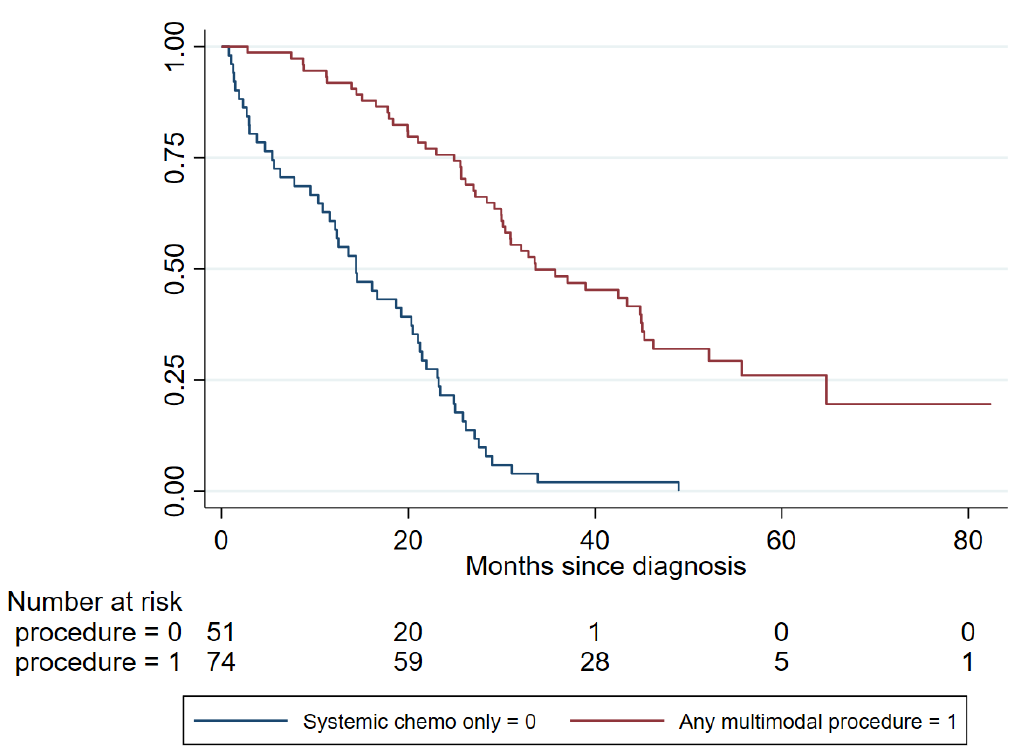
Figure 1. Overall survival of patients undergoing any multimodal procedure compared to those receiving systemic chemotherapy alone.